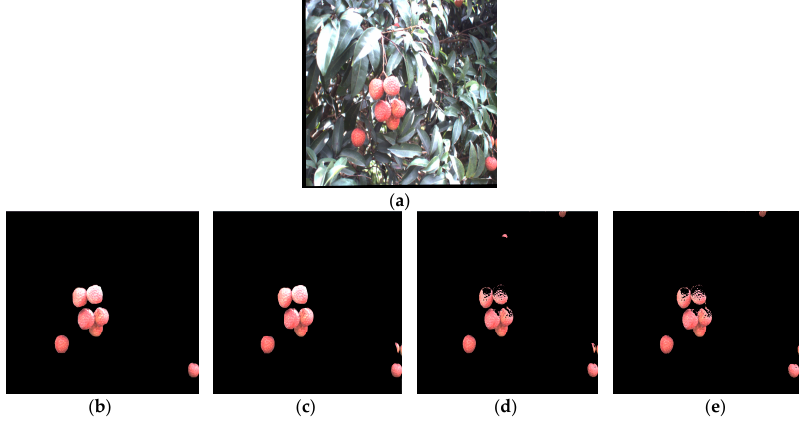
Figure 6. Mature litchi fruits extraction. ( a ) Original litchi color image; ( b ) Mature litchi fruit extraction